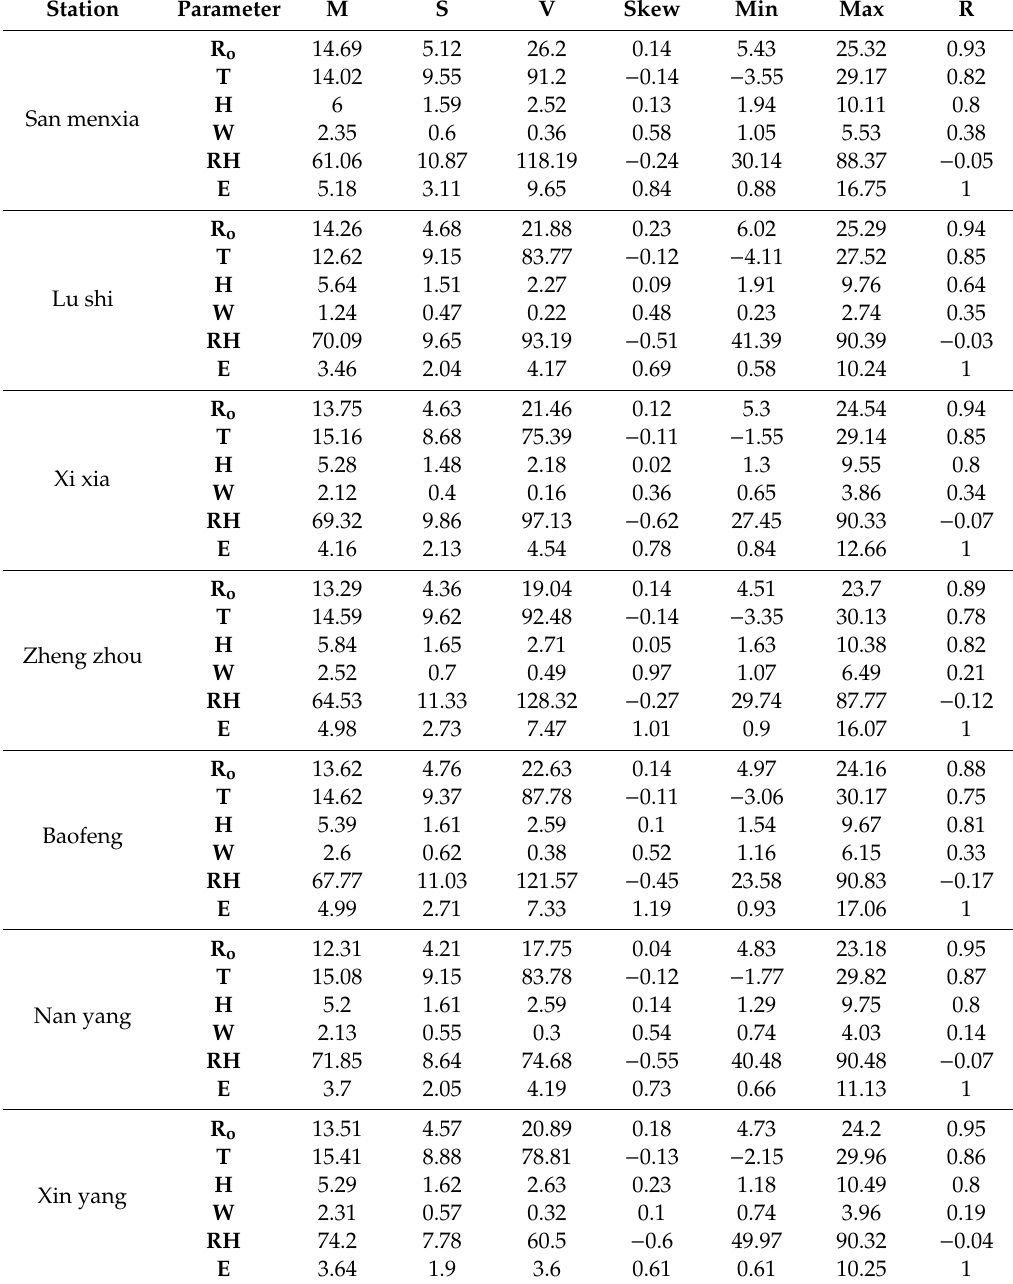
Table 2. Monthly mean values of meteorological variables for each observation station.